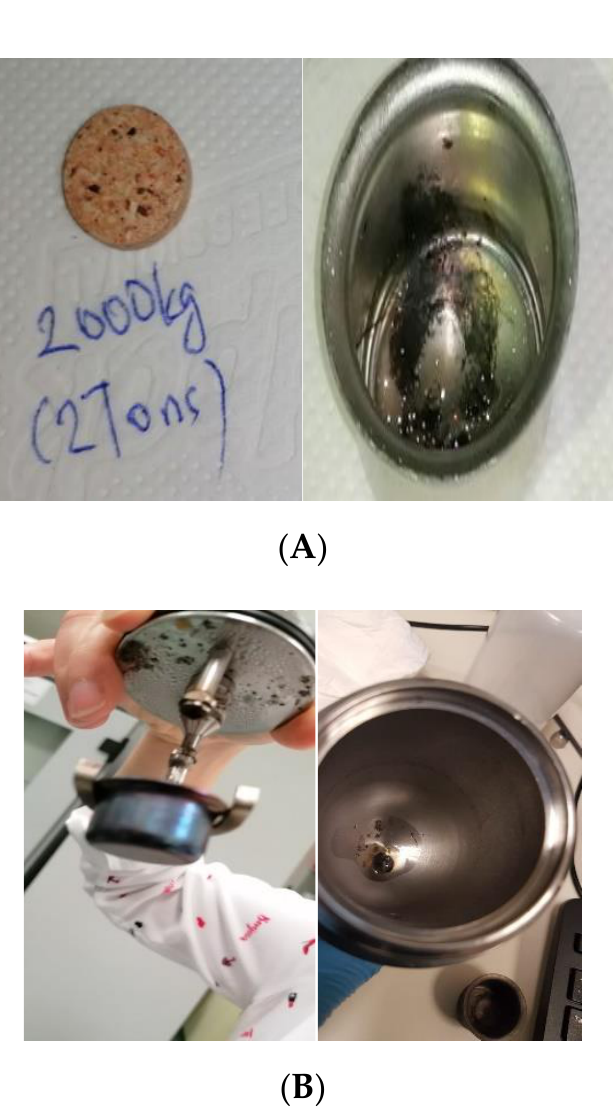
Figure 3. Impact of the applied pellet pressure on achieving complete combustion, ( A ) shows the pellet under 2 ton ( B ) shows the pellet under 10 tons, as mentioned in the standard. pellet under 2 ton ( B ) shows the pellet under 10 tons, as mentioned in the